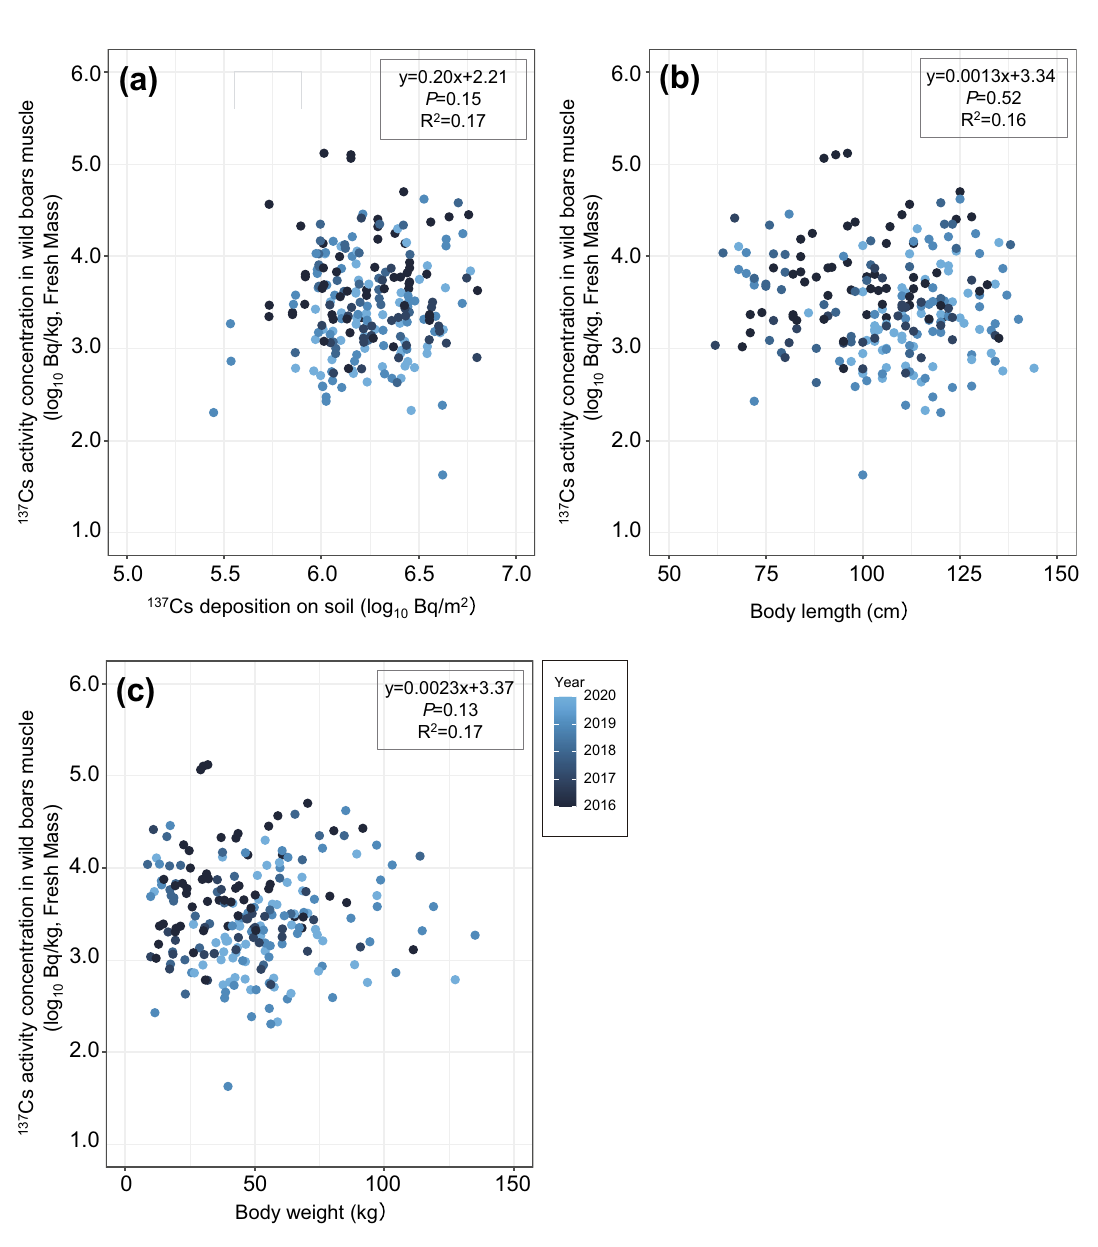
Figure 4. Relationships between 137 Cs activity concentration in wild boar muscle samples collected in all seasons and ( a ) 137 Cs deposition on soil (log 10 Bq/m 2 ), ( b ) body length (cm), and ( c ) body weight (kg) inside the difficult-to-return zone (DRZ). Results of the regression analysis are based on mixed linear models using years as random variables and the adjusted coefficient of determination (R 2 ) are shown in the